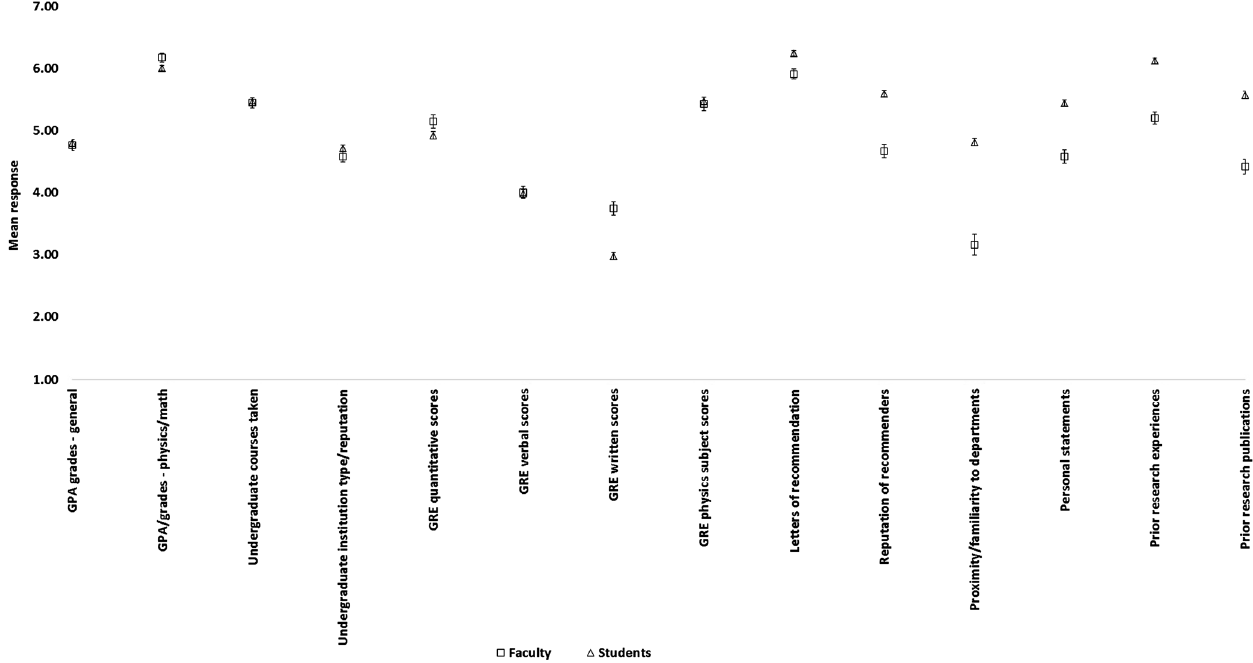
FIG. 1. Mean response of 14 admission criteria ranking of student ( N ¼ 802 ) and admission-associated faculty ( N ¼ 149 ) groups.